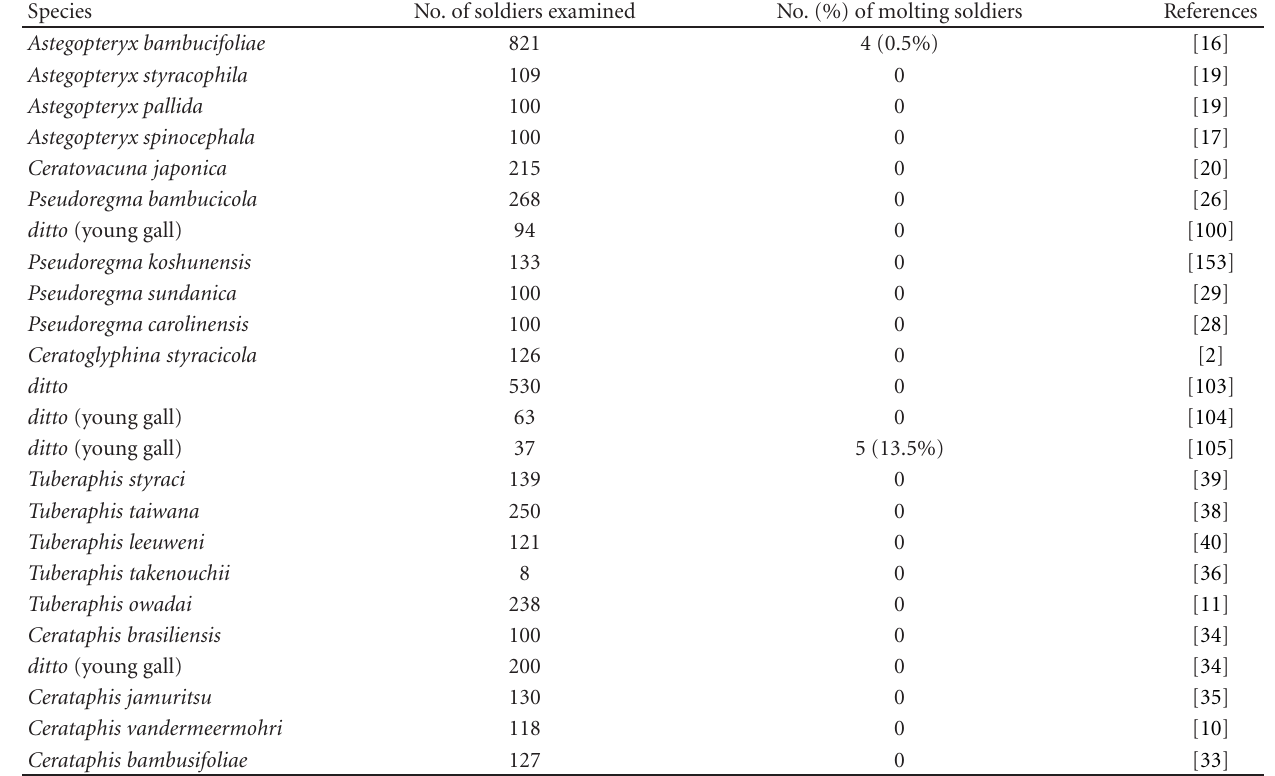
Table 4: Molting rate of cerataphidine soldiers in Styrax